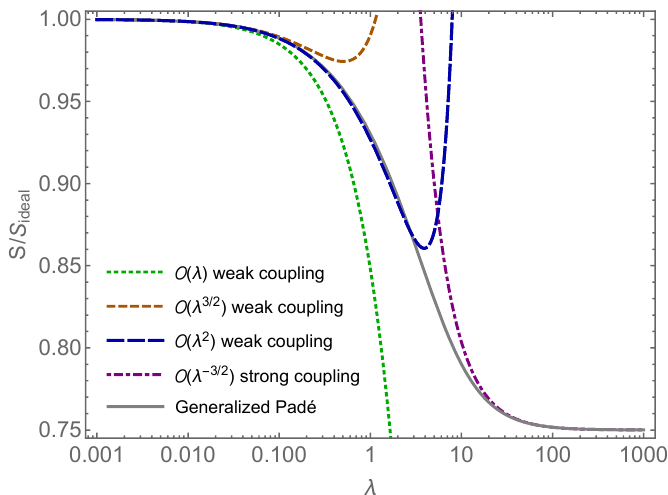
Figure 5 . SYM 4 , 4 scaled entropy density S / S ideal as a function of λ . The green dotted, red dashed, and blue long-dashed curves correspond to the perturbative result truncated at O ( λ ) , O ( λ 3 / 2 ) , and O ( λ 2 ) , respectively. The purple dot-dashed curve corresponds to the large- N c strong-coupling result truncated at O ( λ − 3 / 2 ) . The solid gray line is a generalized Padé that interpolates between the known weak- and strong-coupling